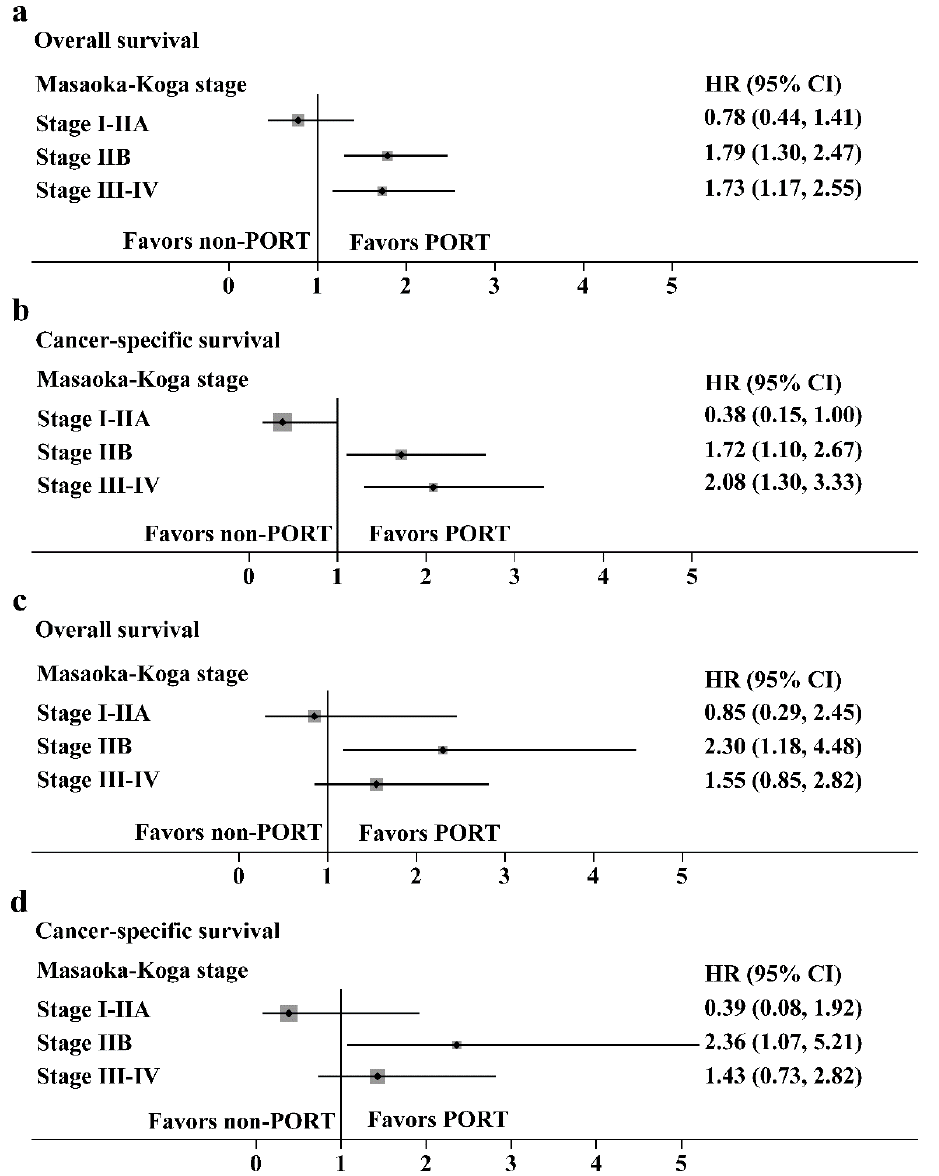
Figure 6. Subgroup analysis with the Cox regression model. ( a , b ) Hazard ratios with 95% CI for the overall survival and cancer-specific survival in thymoma stratified by the Masaoka-Koga stage. ( c , d ) Hazard ratios with 95% CI for the overall survival and cancer-specific survival in thymic carcinoma stratified by the Masaoka-Koga stage.